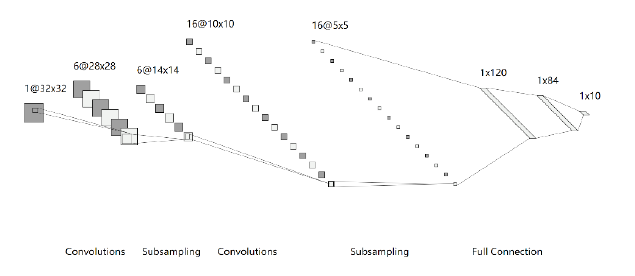
Figure 4. Convolution process of LeNet